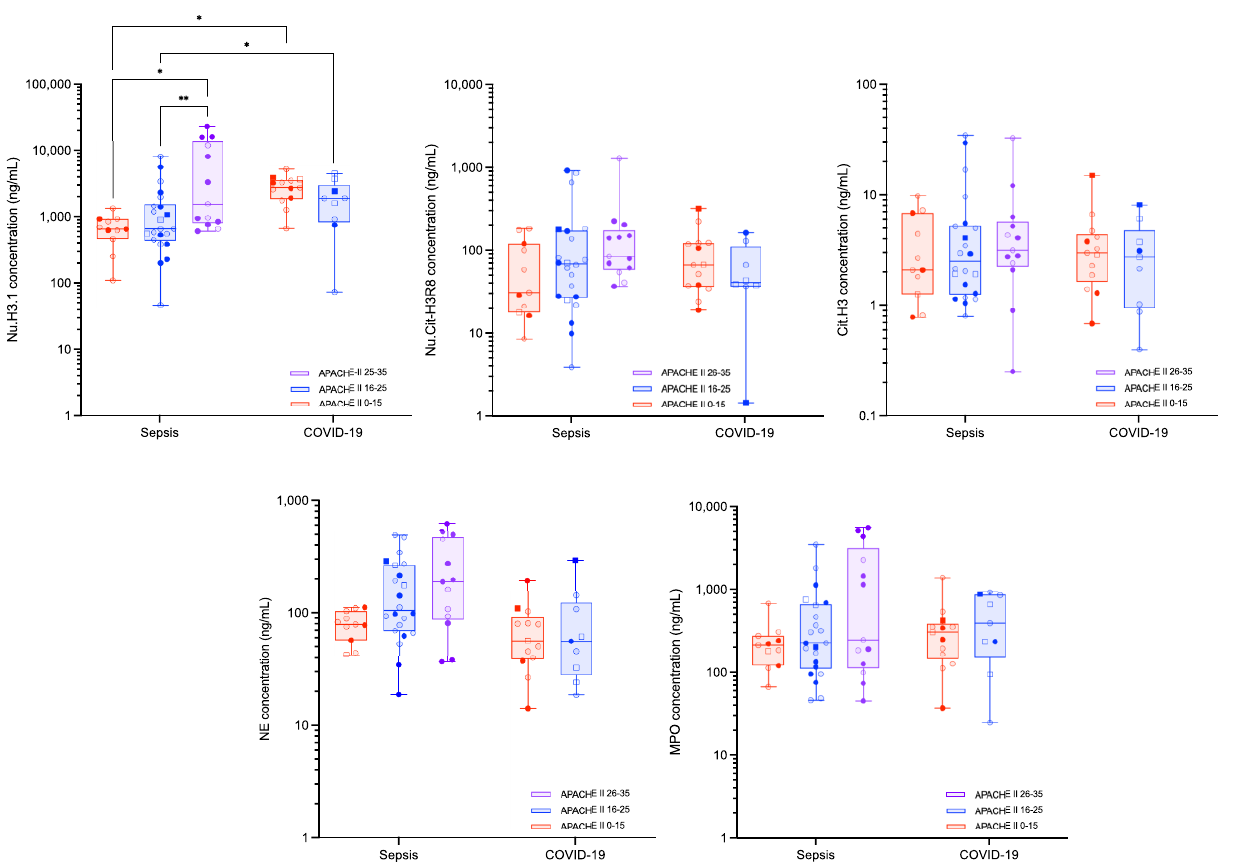
Figure 3. Circulating nucleosomes and neutrophil activation parameters in septic shock and critical COVID-19 subjects according to the APACHE-II score . Boxes represent 25th – 75th percentile with median. Whiskers represent min to max variation. Squares represent patients with a thromboembolic event, and non-transparent symbols represent dead patients. *, ** represent p - values ≤ 0.05 and ≤0.01, respectively. Only differences that are statistically significant are reported. Abbreviations: Cit-H3, citrullinated histone H3 (citrullinated in R2, R8 and R17); MPO, myeloperoxidase; NE, neutrophil elastase; Nu.Cit-H3R8, citrullinated H3R8-nucleosome; Nu.H3.1, H3.1-nucleosome.